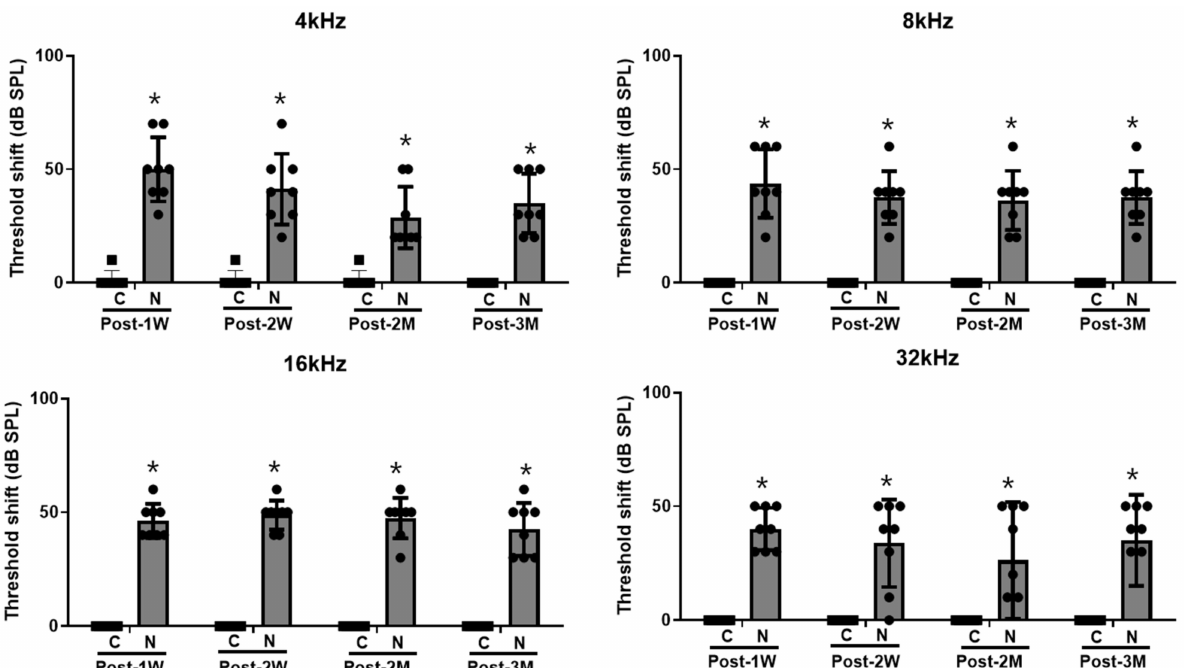
Figure 2. Hearing threshold shifts after noise exposure ( n = 8 per group). The noise exposed rats demonstrated hearing threshold shifts at 1 week, 2 weeks, 2 months, and 3 months post noise exposure at 4, 8, 16, and 32 kHz. (* p < 0.05; unpaired t -test between the control and noise-exposed groups; C: control rats; N: noise